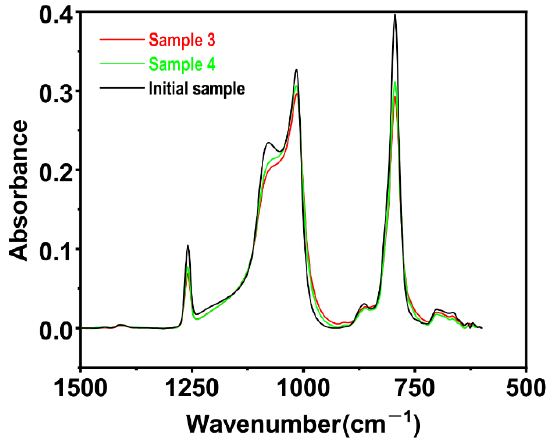
Figure 10. Infrared absorption spectra for the initial sample and samples 3 and 4.